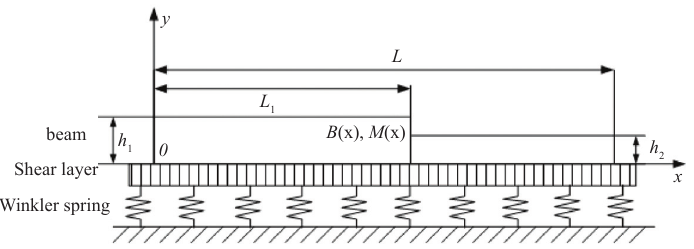
Fig. 4. The sketch of one stepped beam on Pasternak